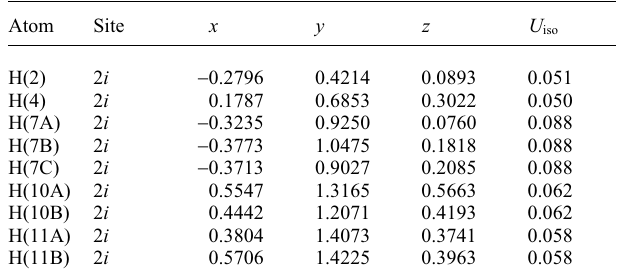
Table 2. Atomic coordinates and displacement parameters (in Å 2 ) . Table 1. Data collection and handling.